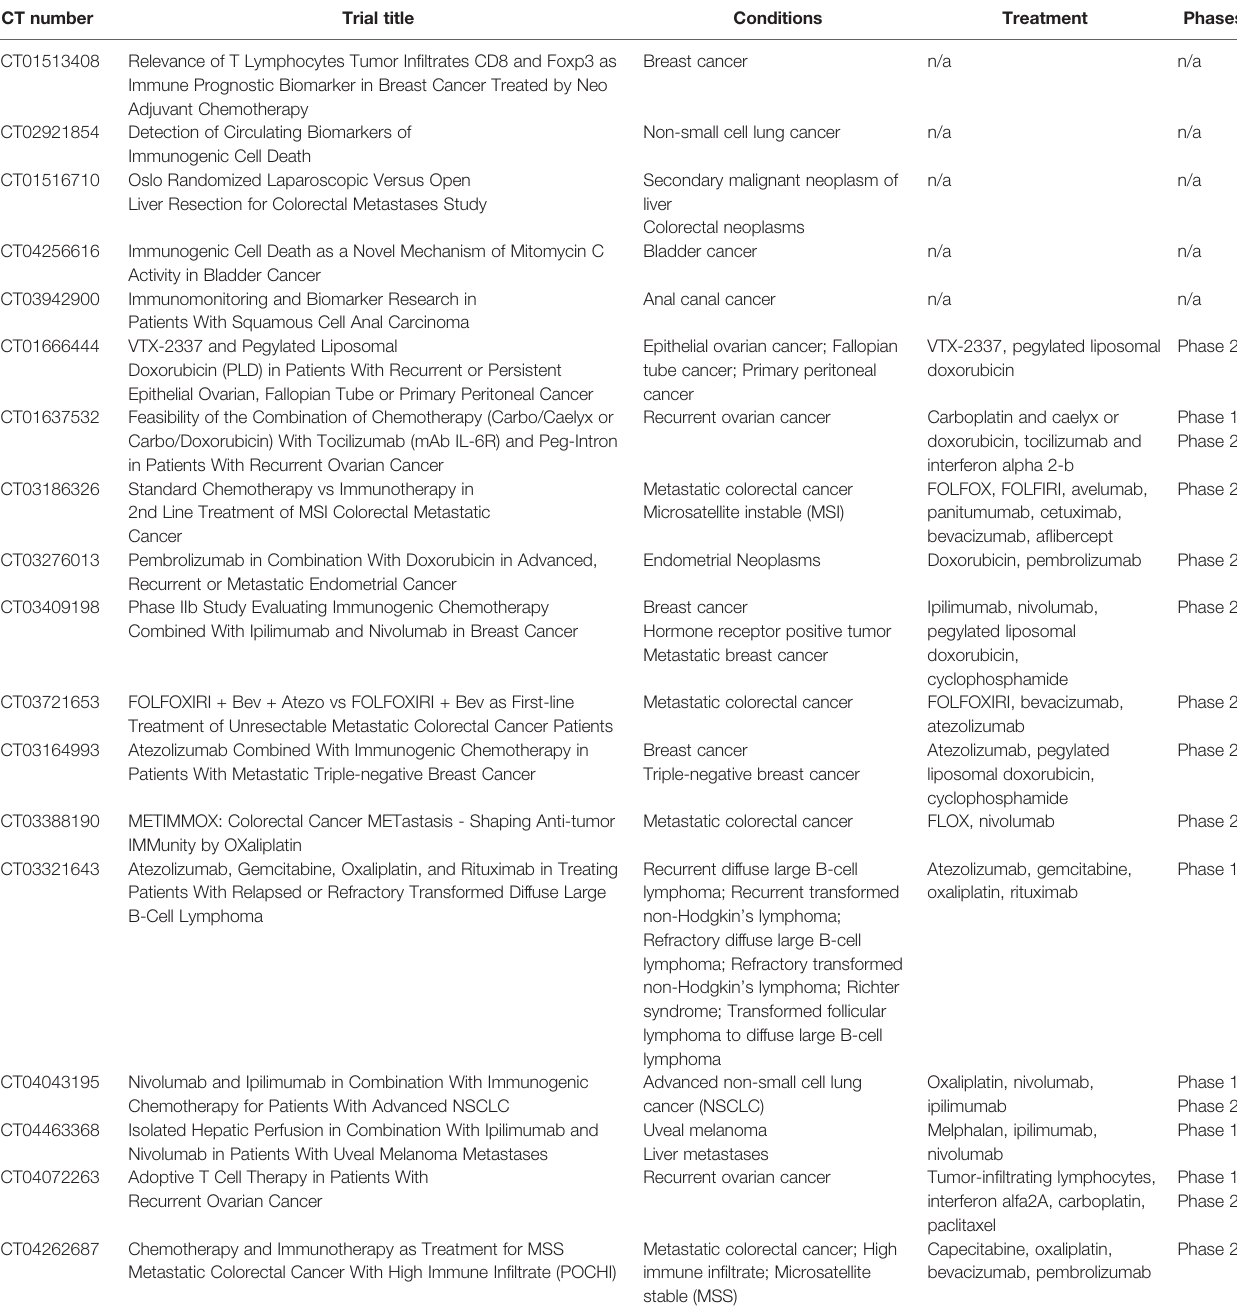
TABLE 3 | Clinical trials investigating immunogenic cell